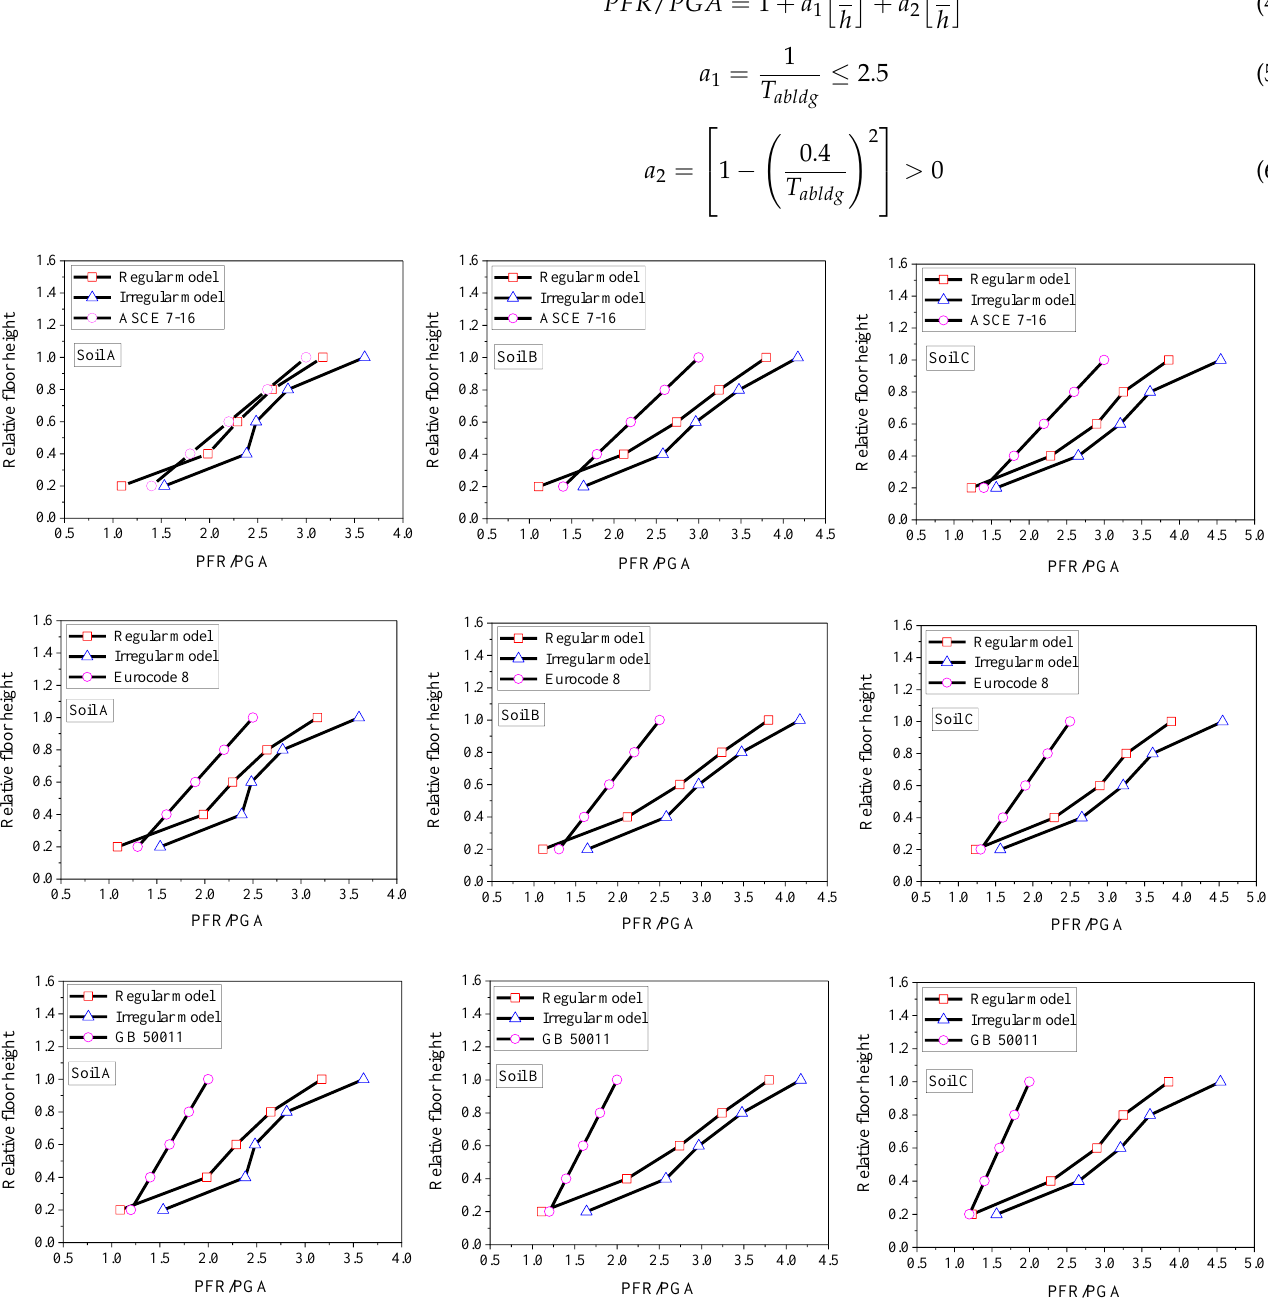
Figure 10. Comparison of floor amplification factors between the considered building models and current codes.